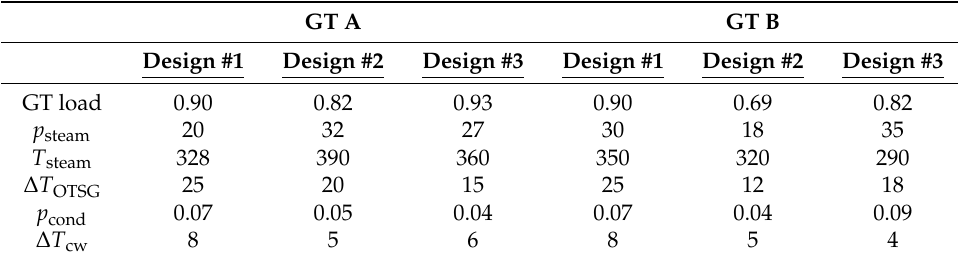
Table A2. Designs selected to test the off-design correlations.